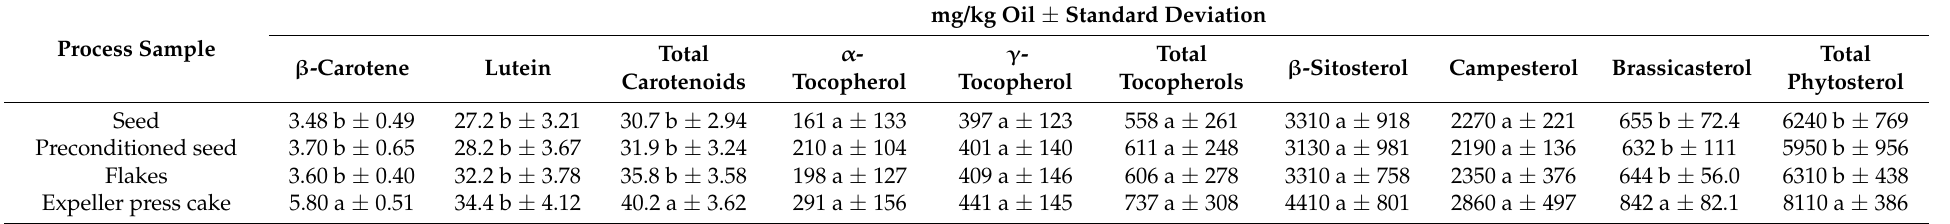
Table 1. Bioactive concentrations in seed, flake, and press cake from process BC.